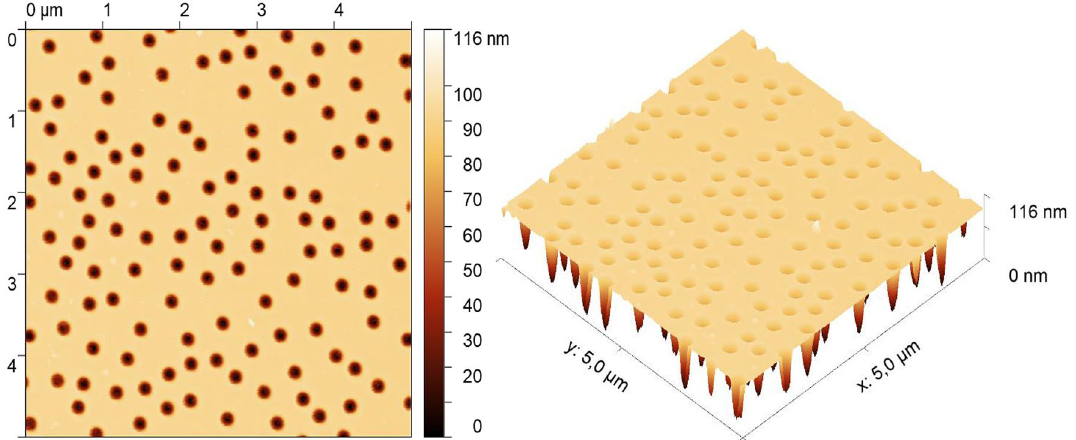
Figure 4. Detailed AFM image of silicon mold with the array consisting of big holes.